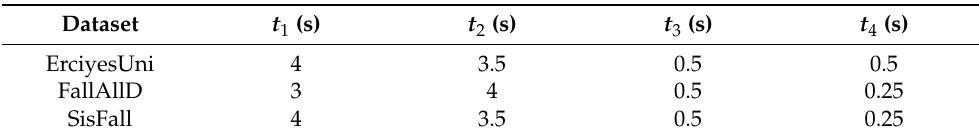
Table 4. Values of parameters t 1–4 for which the best performance is achieved for each dataset when three windows are used for